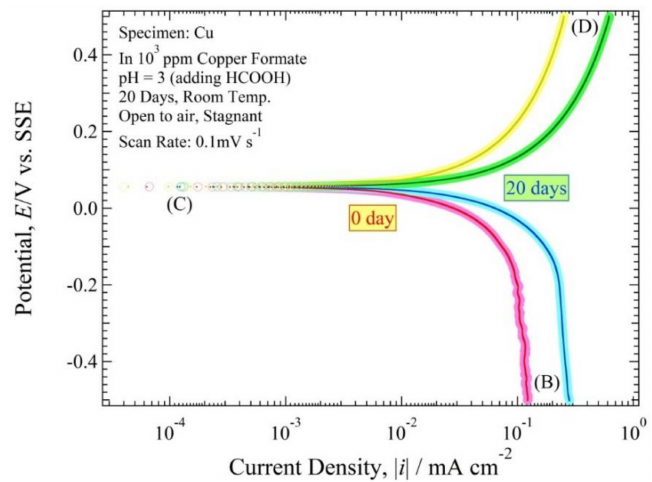
Figure 9. Polarization curve of Cu tube specimen in 10 3 ppm Cu(HCOO) 2 solution at the immersion period of 0 days and 20 days with solution pH